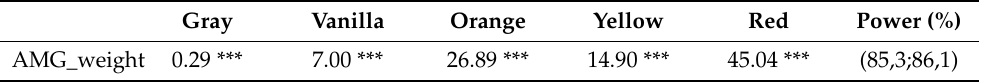
Table 12. Adjusted Morbidity Group (AMG) variables of persons over 65 years of age living alone according to the patient AMG triangle color in Drago-EHRPC. Basic Health Areas of Gran Canaria. 2018–2020.